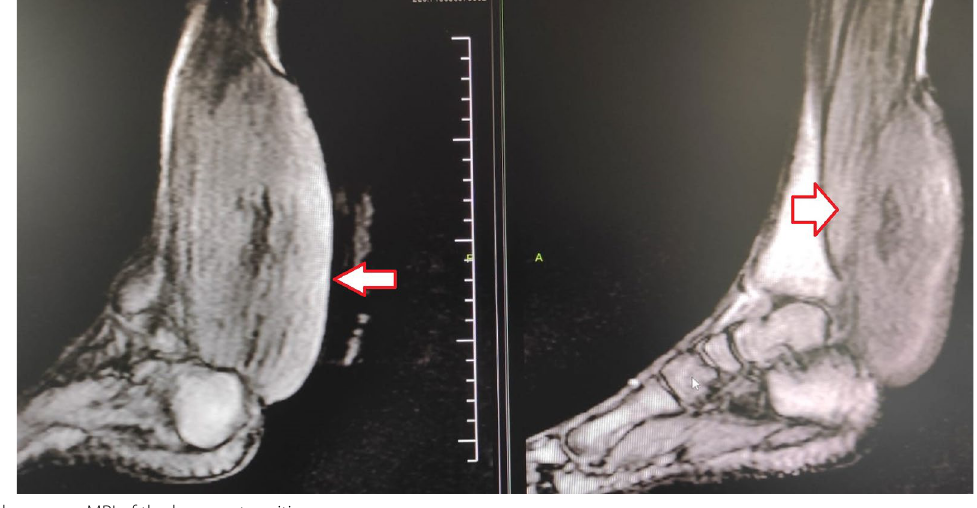
Fig. 2 Xanthomas on MRI of the lower extremities